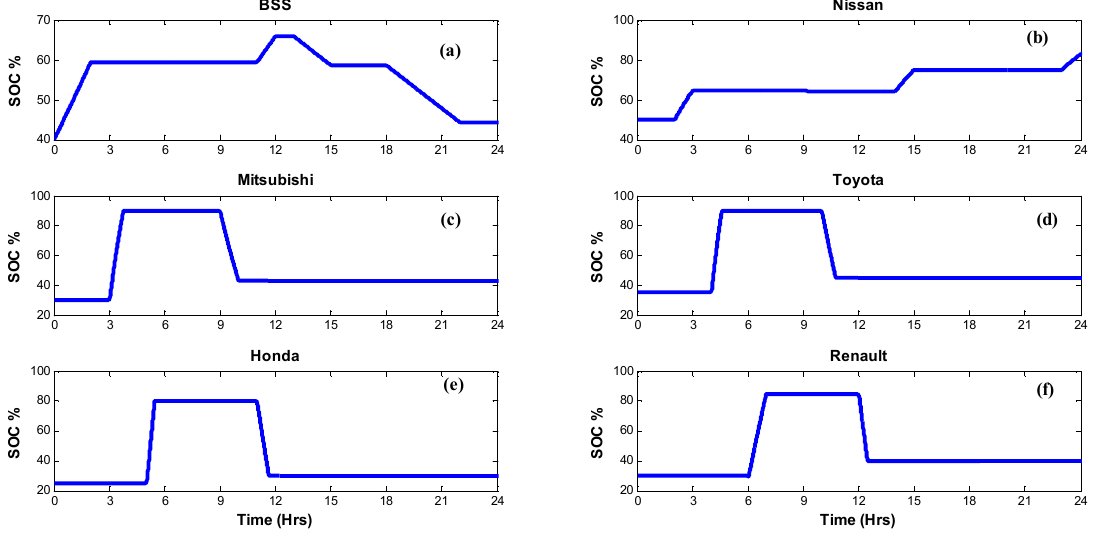
Figure 10. State of charge of the BSS and PHEVs.